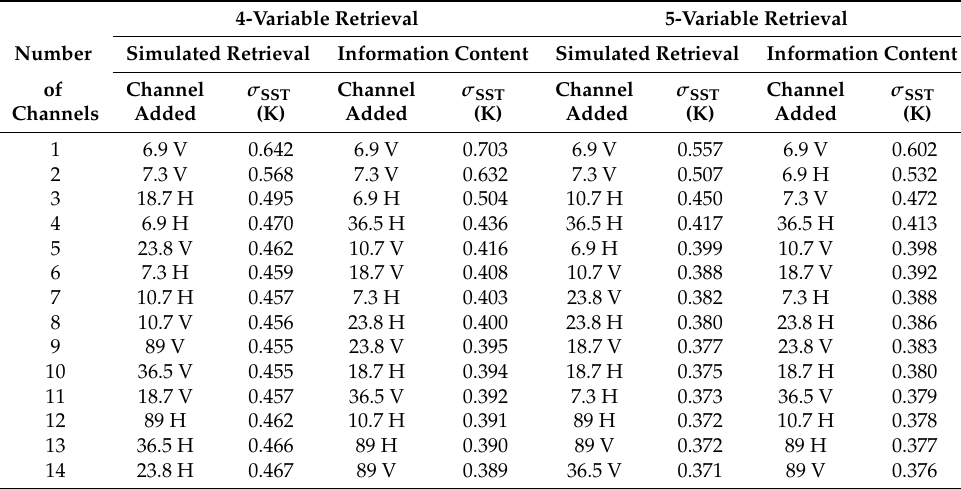
Table 3. The standard deviation of the SST retrieval error and root-mean-squared predicted SST uncertainty from an information content analysis across all profiles for varying numbers of channels with the sensitivity to wind speed doubled in the Jacobian